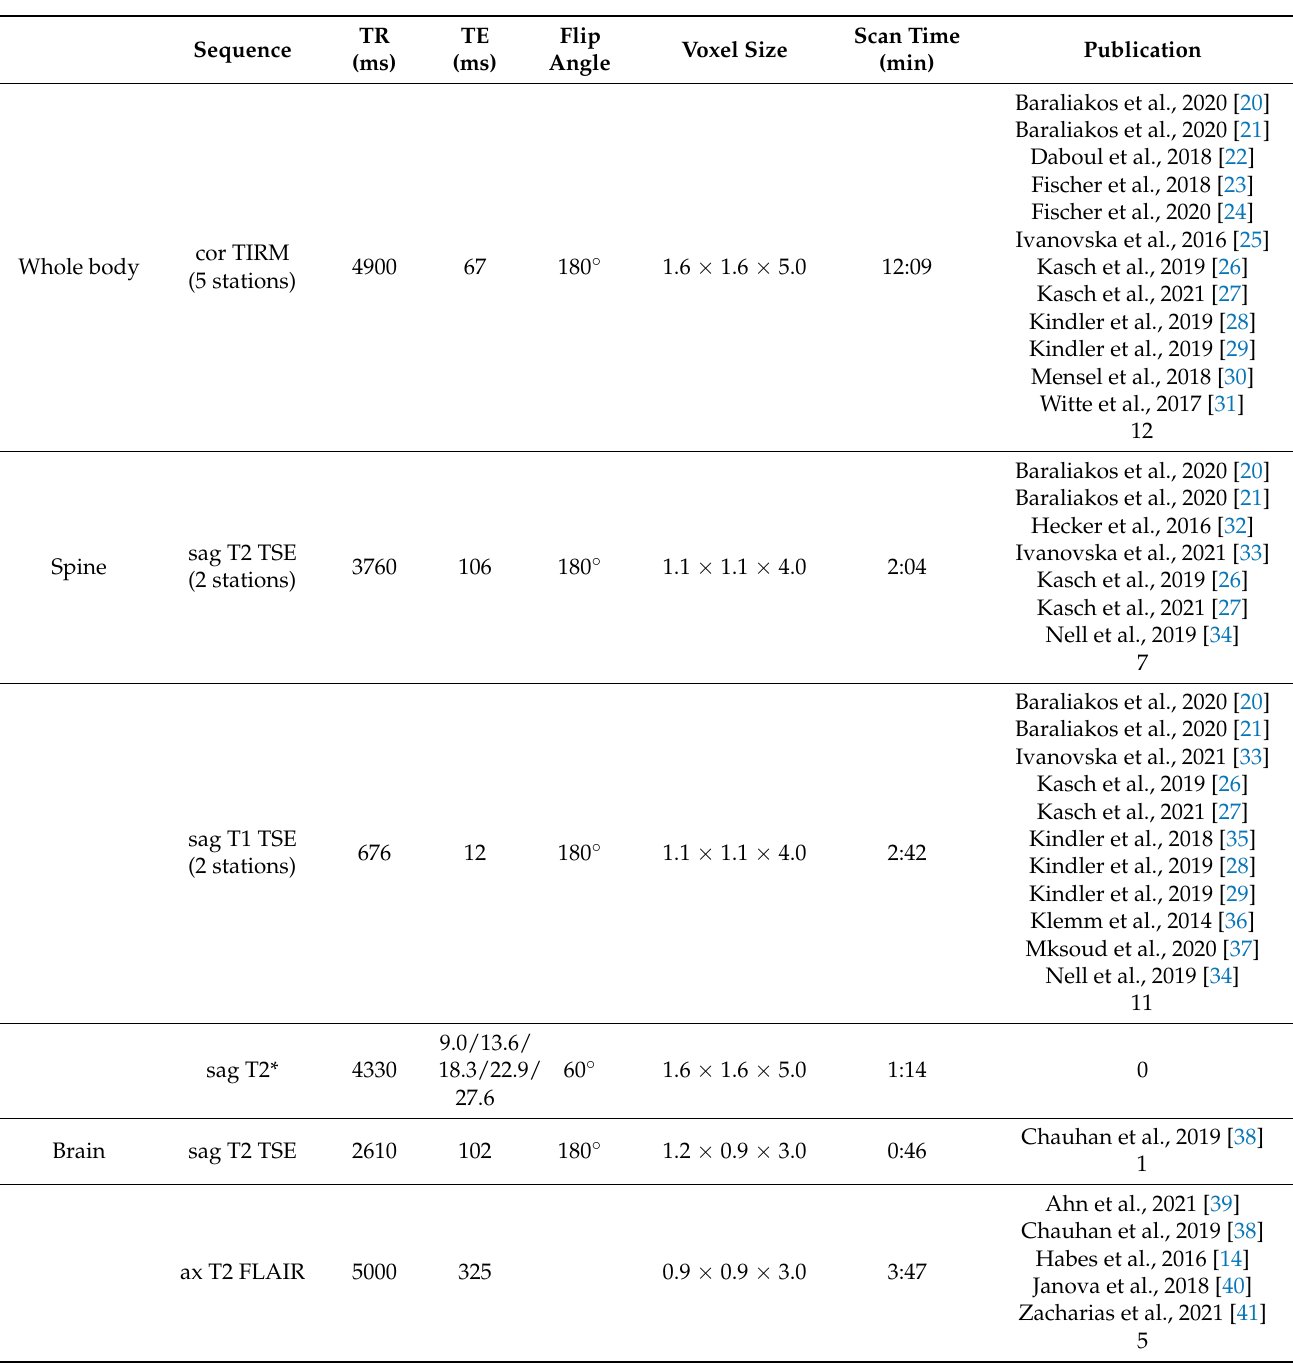
Table 2. The sequences used in the study program with measurement parameters and measurement time, as well as the publications in which they are mentioned in the methodology part. The MPRAGE of the brain as well as the 3D chemical shift sequence of the liver with 2D-GRE R2* mapping sequence of the liver have led to a particularly large number of publications ( n = 20 and n = 17,